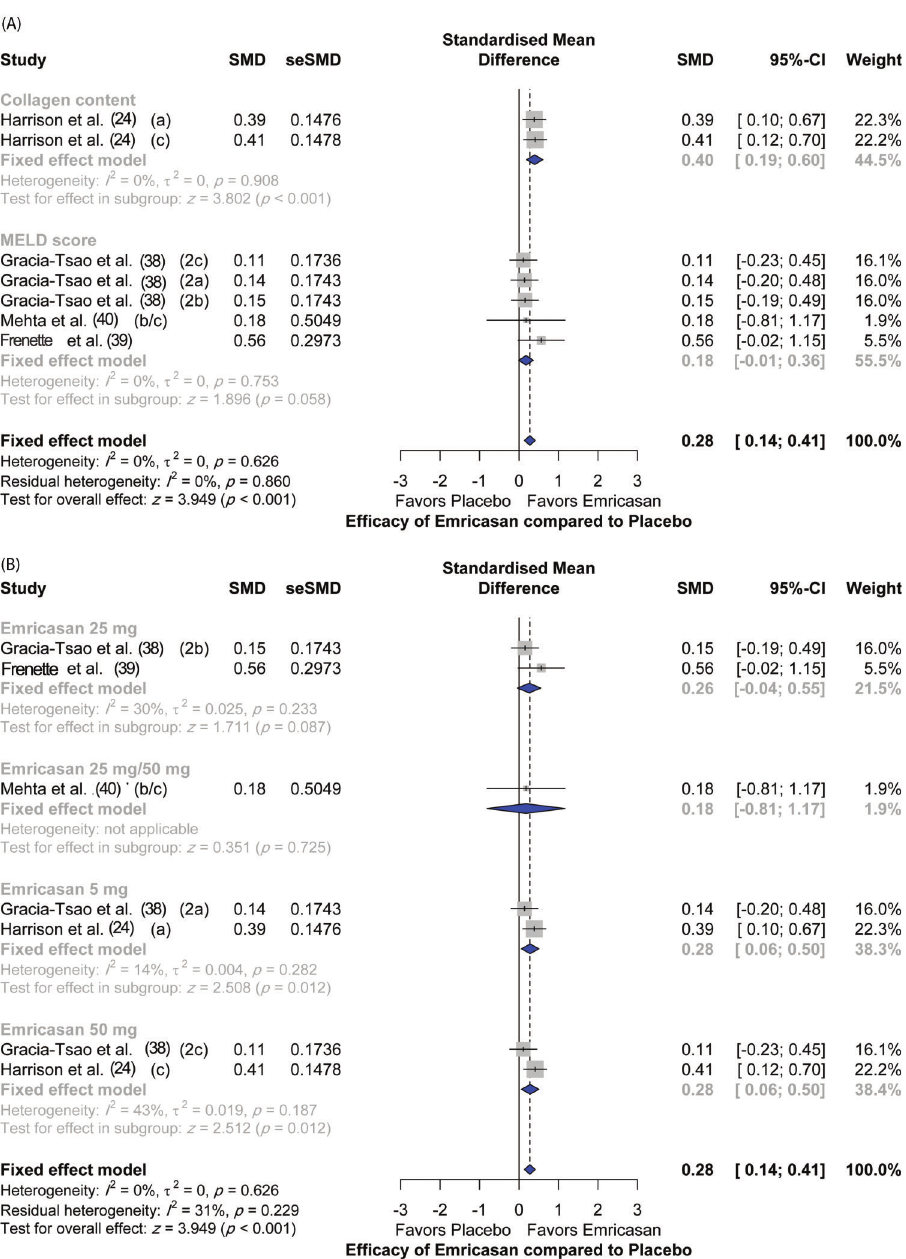
Figure 3 - Main measures of Emricasan efficacy compared to placebo. (A) Assessed outcomes; (B) Dosing regimens: a=5 mg; b=25 mg and c=50